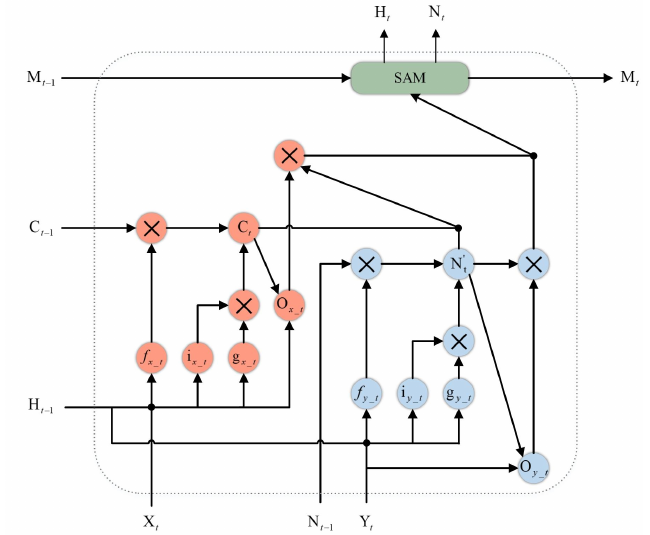
Figure 5. The dual-input early fusion ConvLSTM (EF-ConvLSTM) architecture. The two inputs are 3D tensors, defined as X t and Y t . EF-ConvLSTM forecasts the X t + 1 · · · X t + q in the future given the previous X t − n · · · X t and Y t − n · · · Y t including the current